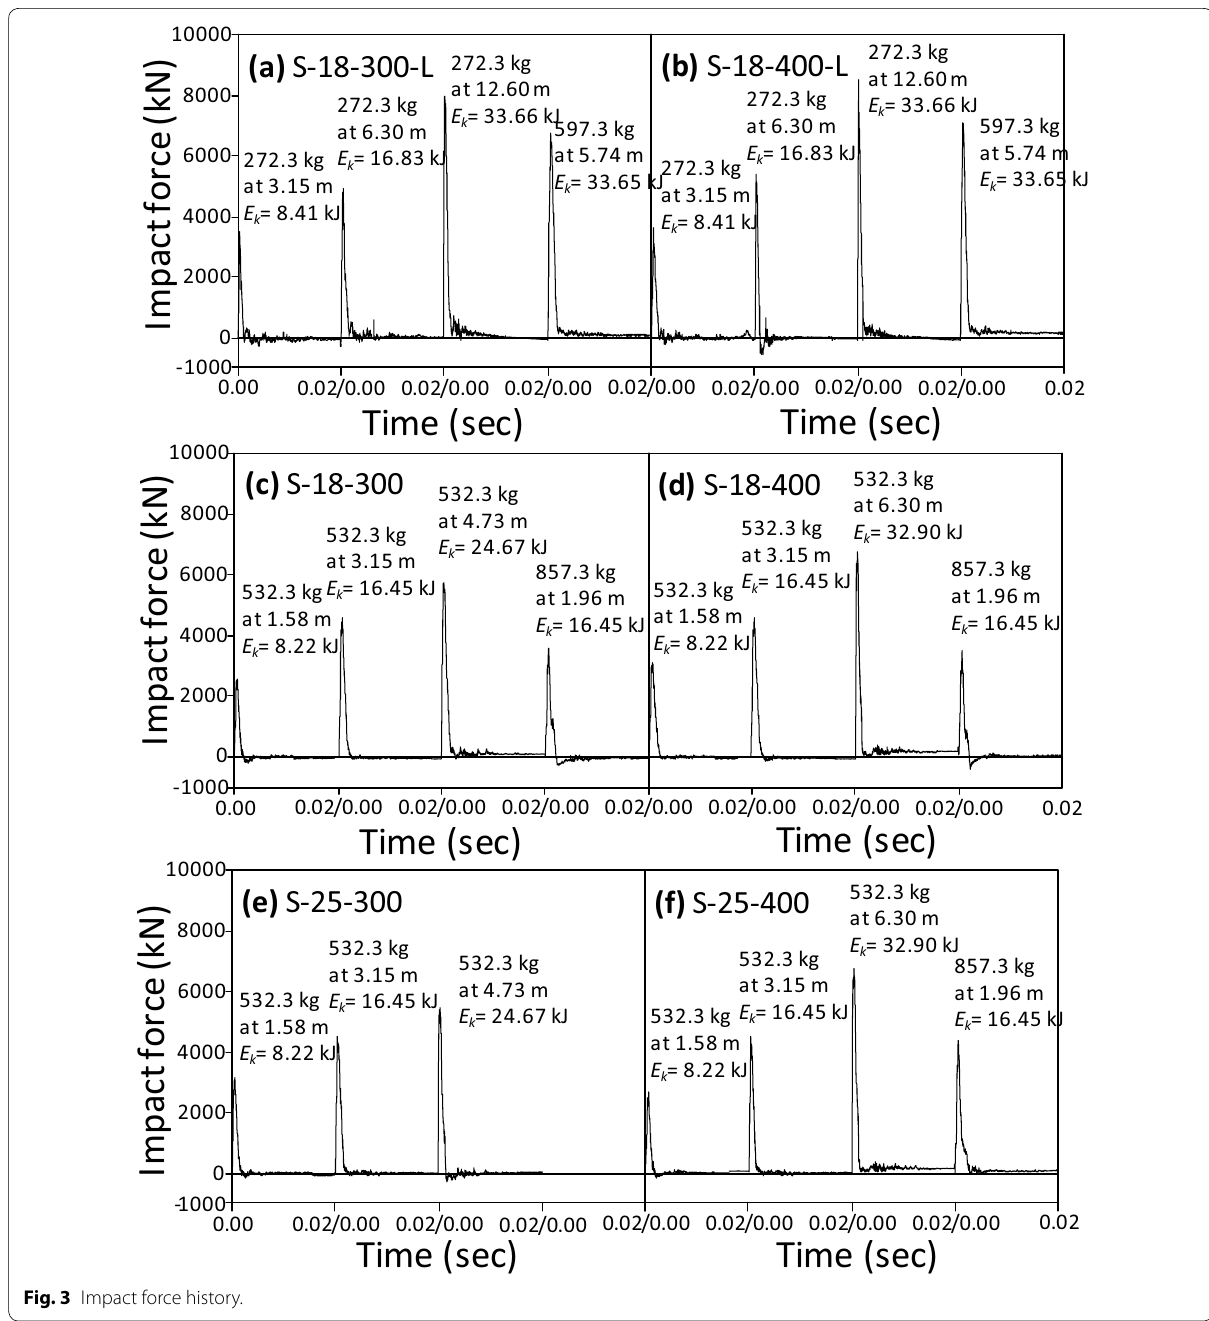
strain ( 0.00249) and dynamic yield strain ( = 0.00285 mm/mm in the drop heights). It is noted that the dynamic yield strain was calculated from the analy- sis results (refer to the chapter of “Deformation Energy E d ”). This result indicates that longitudinal bars can be